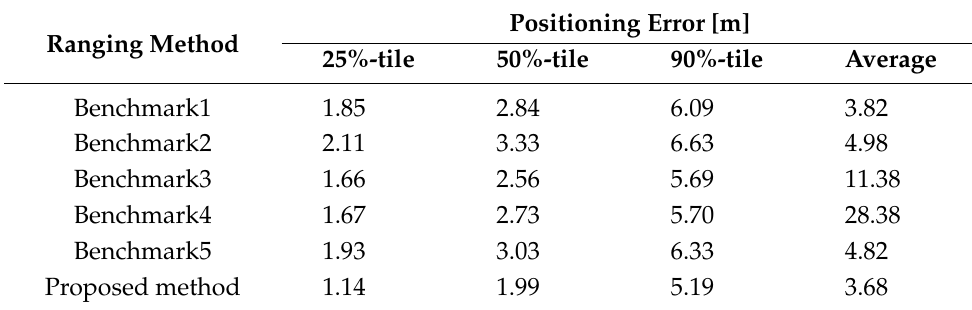
Figure 13. Empirical cumulative distribution function ( a ) and histogram ( b ) of the positioning error. Table 2. Positioning error results for each ranging